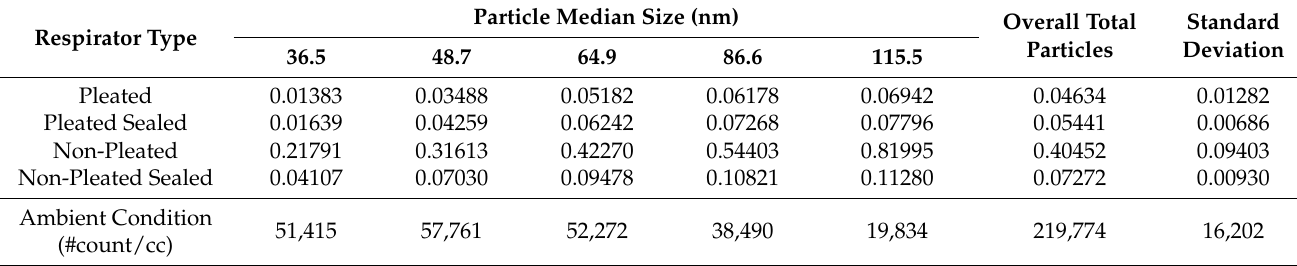
Table 1. Results of average downstream to upstream filtration ratios per type, particle size, and per respirator type at the die casting